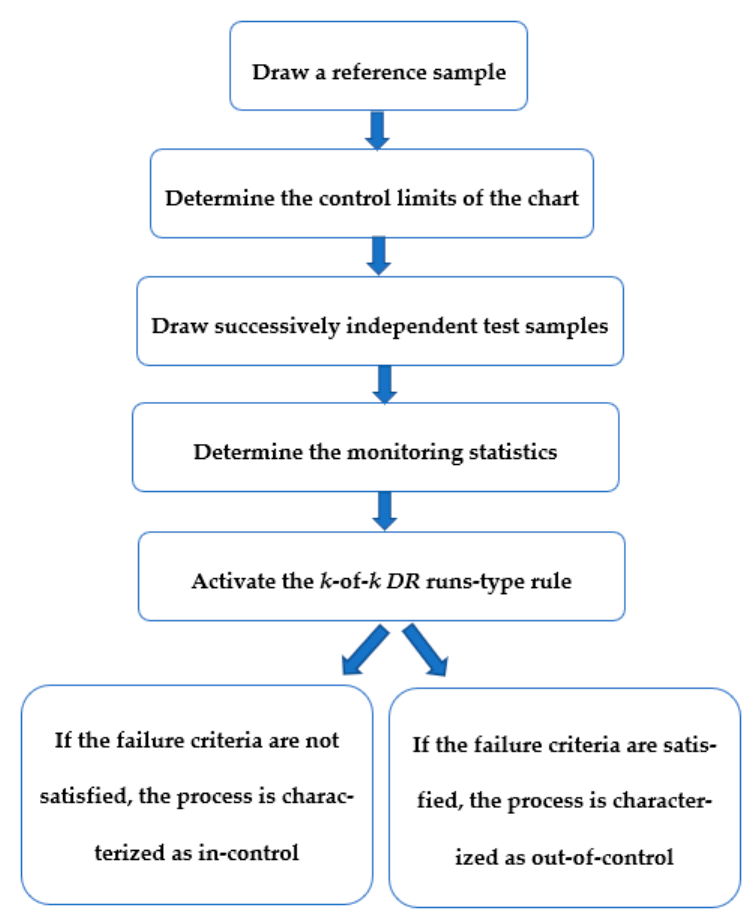
Figure 1. Flowchart of the constructing procedure for the proposed k-out-of-k DR monitoring schemes.